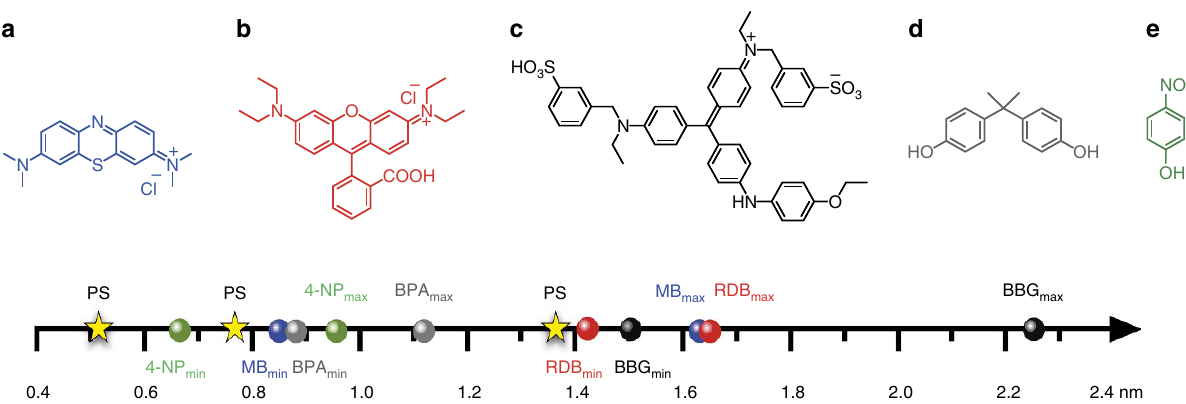
Figure 2 | Substrates that are tested in charge-specific size-dependent separation study. Chemical structure of dye molecules and their calculated van der Waals diameters in a scale bar; ( a ) MB (blue sphere on scale bar), ( b ) RDB (red sphere), ( c ) BBG (black sphere), ( d ) BPA (grey sphere) and ( e ) 4-NP (green sphere). The min and max subscripts indicate minimum and maximum projection diameter of dyes, respectively. pore size (star) indicates three accessible pore sizes existing in COP-99.